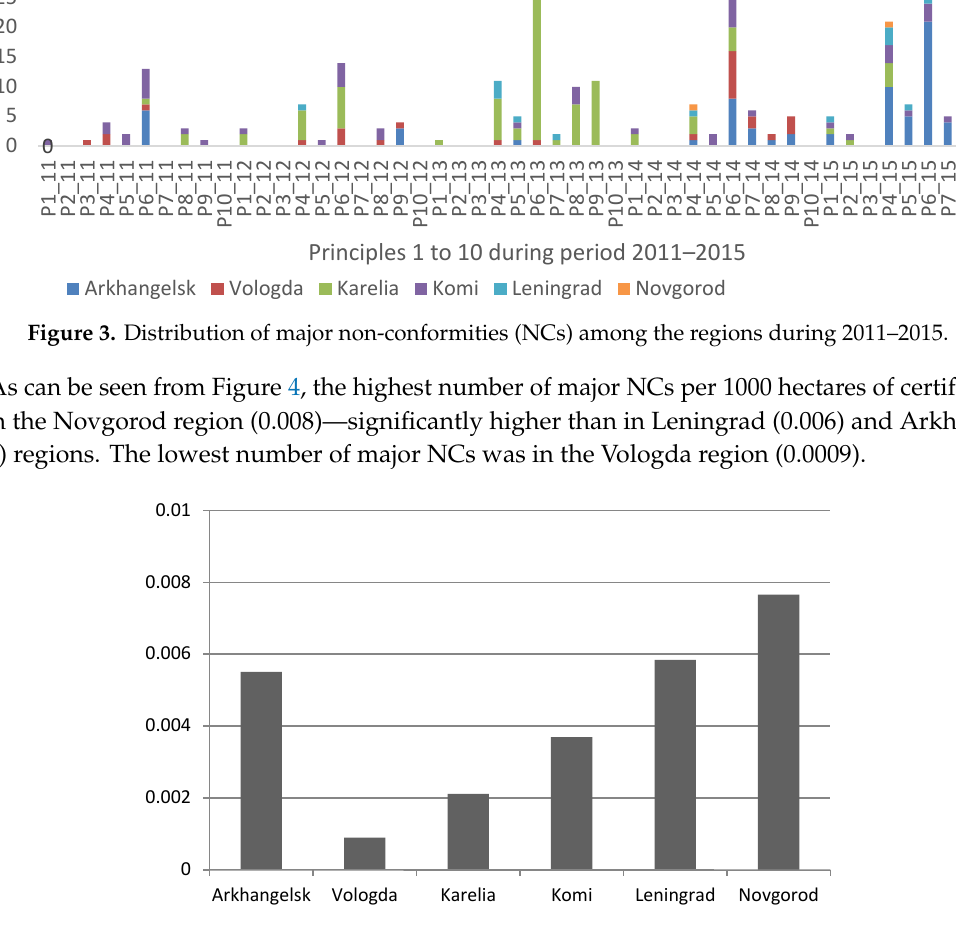
Figure 4. Total number of major NCs per 1000 ha of certified forests among regions in 2015.